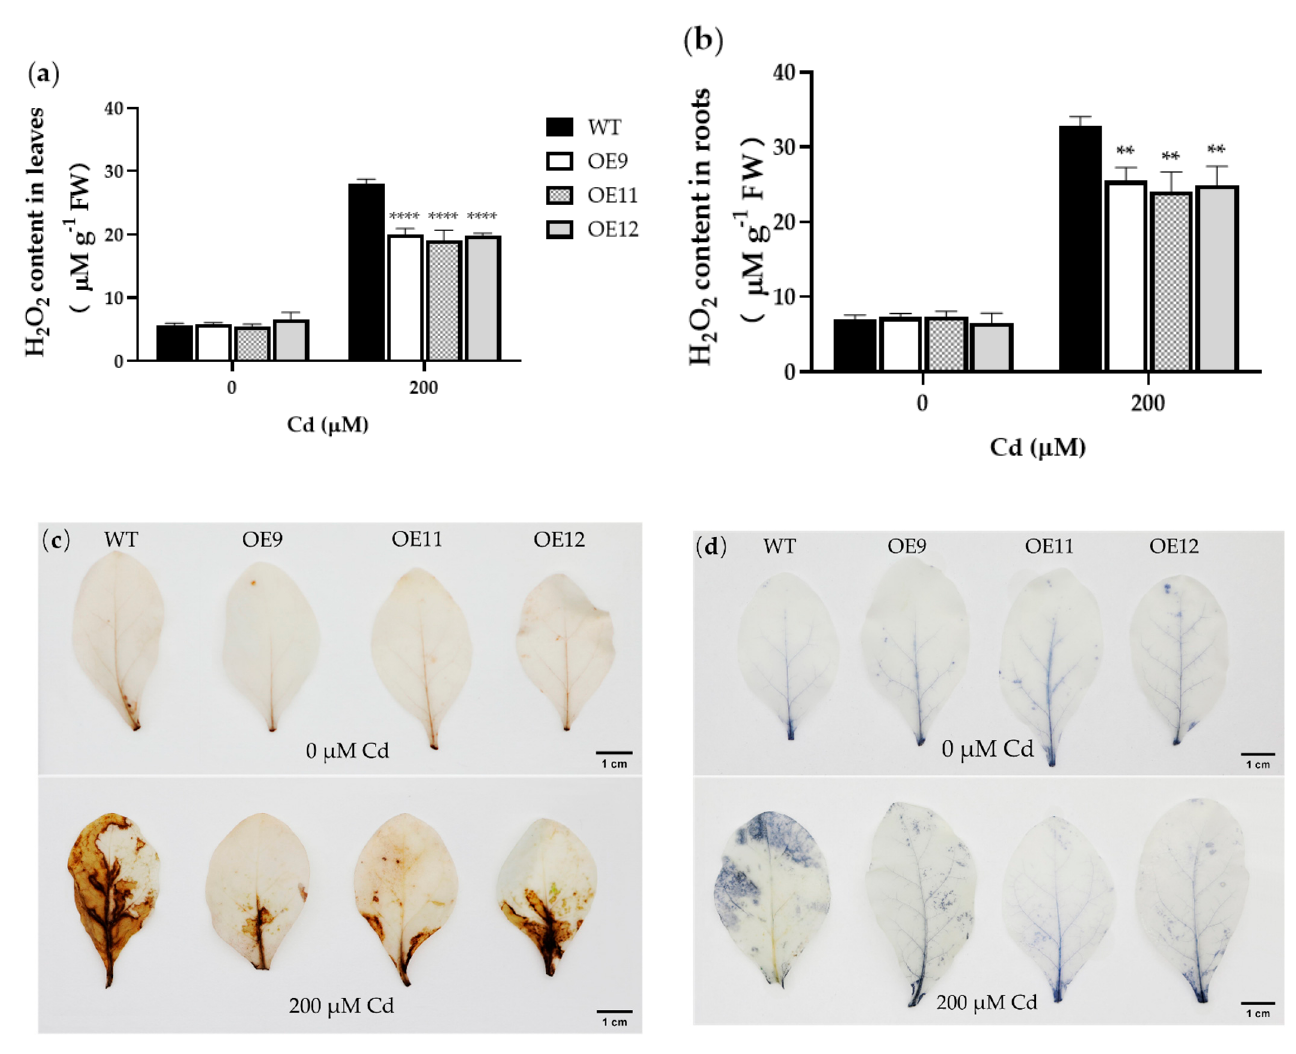
Figure 6. H 2 O 2 content, DAB, and NBT staining under 0 or 200 µ M Cd in wild-type (WT) and transgenic tobacco plants (OE9, OE11, and OE12). ( a ) H 2 O 2 content in leaves. ( b ) H 2 O 2 content in roots. ( c ) DAB staining. ( d ) NBT staining. Data represent the means ± SD ( n = 3). Asterisks indicate a significant difference between the transgenic lines and the WT (**, p < 0.01; ****, p < 0.0001).